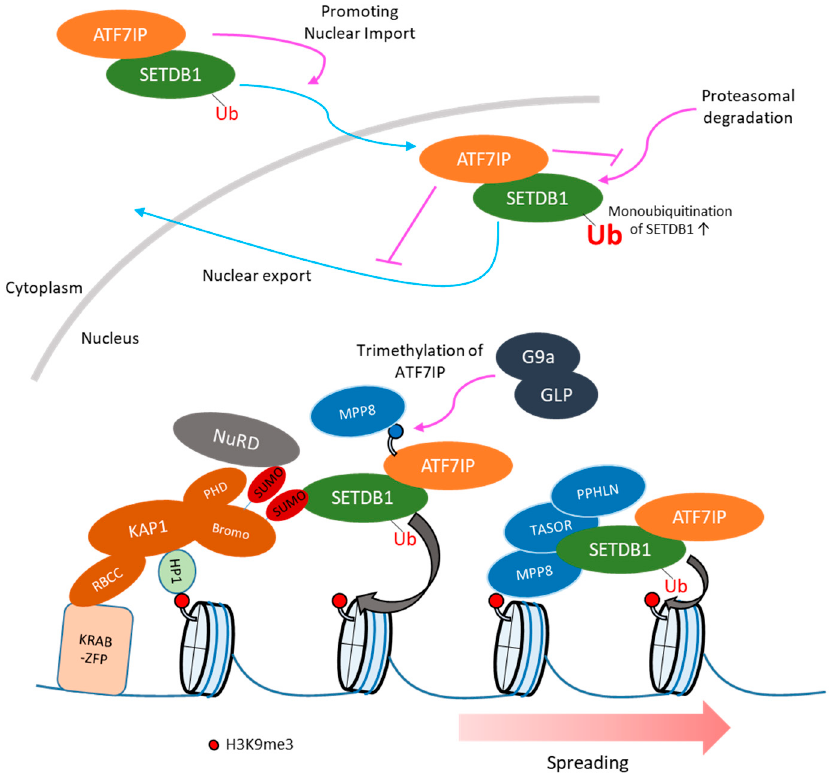
Figure 2. SETDB1 recruitment and H3K9me3 spreading. SETDB1 is mainly localized in cytoplasm and nuclear SETDB1 is degraded by proteasomal pathway [65]. ATF7IP promotes nuclear import of SETDB1 and inhibits nuclear export and proteasomal degradation of SETDB1 [70]. In addition, ATF7IP-mediated SETDB1 nuclear accumulation enhances its ubiquitinated, enzymatically more active form [70]. SETDB1 interacts with SUMOylated KAP1 and is recruited to retroelement by KRAB-ZFP / KAP1 pathway, then SETDB1 mediates H3K9me3 in retroelement [41]. The Human Silencing Hub (HUSH) component bind H3K9me3 via chromodomain of MPP8, which might require for H3K9me3 spreading [76]. ATF7IP harbors H3K9-like sequence, which is methylated by G9a / GLP. The methylation of ATF7IP is recognized by MPP8 and the residue methylated by G9a / GLP is required for e ffi cient provirus silencing [77]. The HUSH complex might be recruited to SETDB1 target via interaction between methylated ATF7IP and MPP8.